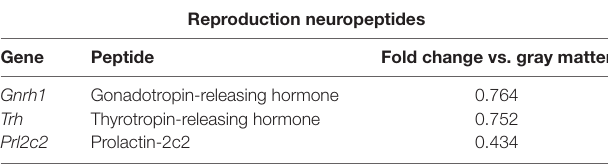
TABLE 3 | Neuropeptides in the PVT with known roles in reproduction, as identified with the Allen Brain